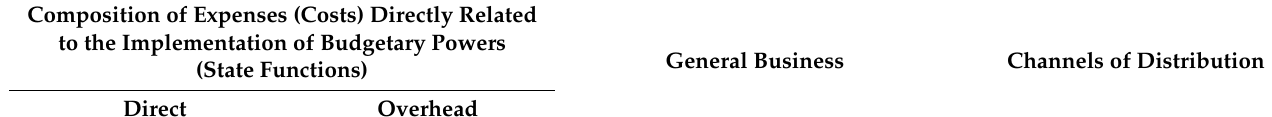
Table 2. The proposed distribution of costs (expenses) of functional and professional areas of the Federal